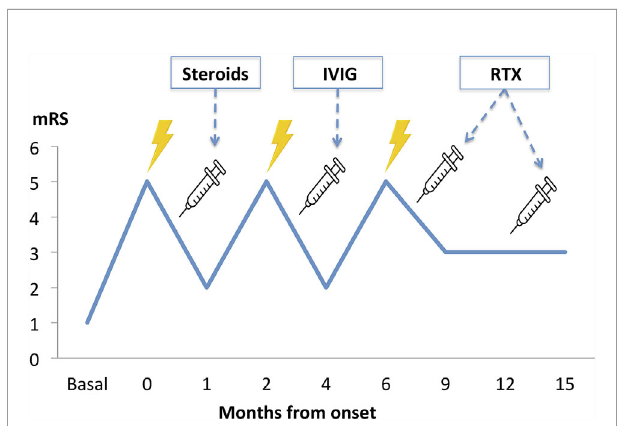
FIGURE 3 | Clinical course timeline during the fi rst 15 months of follow-up, with three clinical relapses and subsequent improvement after immunotherapy administration. IVIG, intravenous immunoglobulins; mRS, modi fi ed Rankin score; RTX,